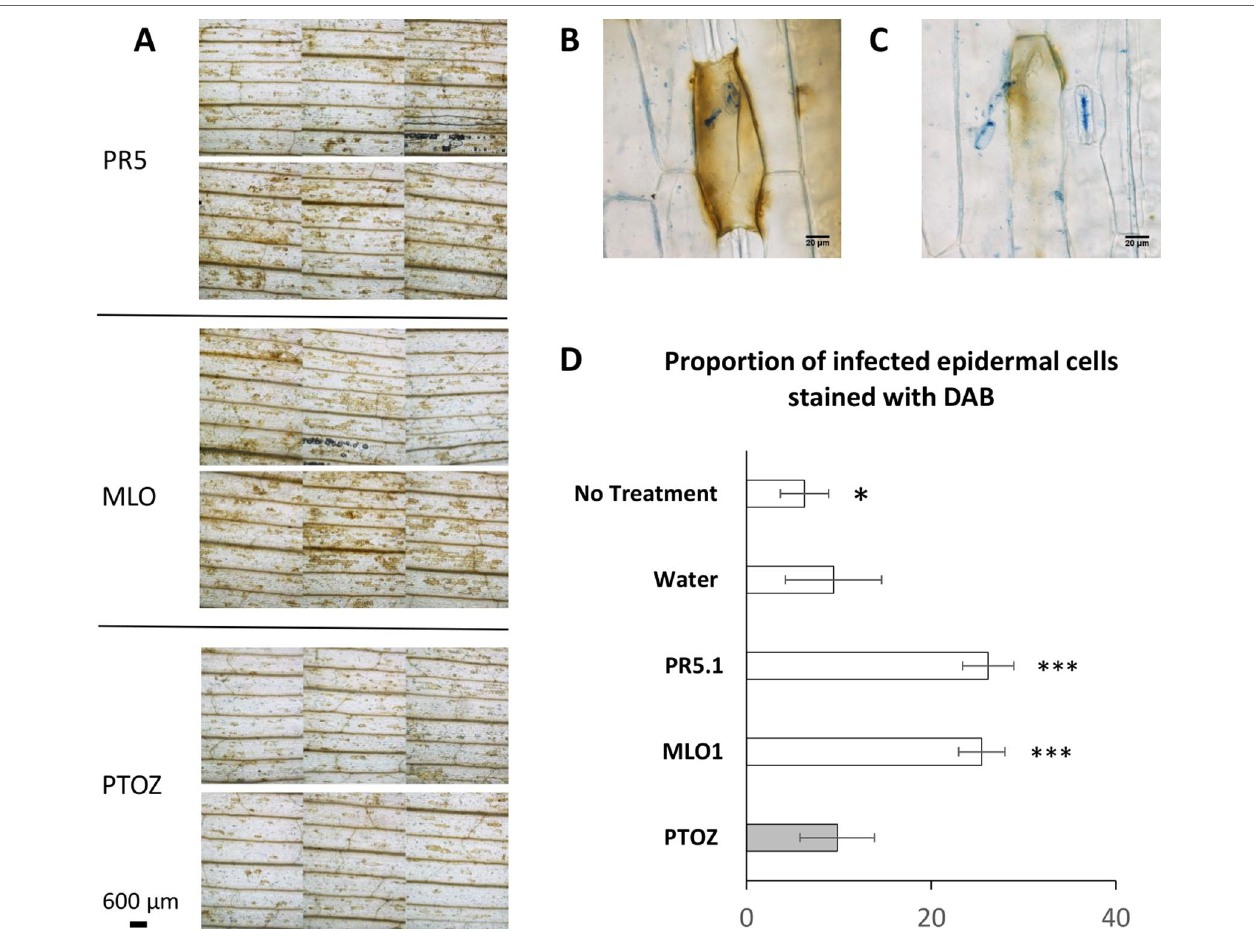
FIGURE 6 | PTO MLO1-, PTO PR5.1-, and PTOZ-treated leaves, inoculated with Bgh conidia, were stained with 3,3 ′ -diaminobenzidine (DAB) to detect H 2 O 2 production in barley epidermal cells in response to Bgh inoculation at 18–22 hpi. Leaves were subsequently stained and cleared with lactophenol blue to visualize fungal structures and DAB-stained epidermal cells. (A) , Micrographs of PTO PR5.1-, PTO MLO1-, and PTOZ-treated leaves showing different intensities of DAB staining. Six panels are shown for each treatment, corresponding to each individual leaf from a typical experiment. Pictures were taken at 1.5 cm from the leaf tip, in bright field settings, at 40× magnification. (B – C) , Illustration of a DAB-stained barley cell indicating two degrees of H 2 O 2 production in response to a germinated Bgh conidium. (D) , Graph showing the average (± SD) proportion of epidermal cells producing H 2 O 2 following Bgh infection. This was monitored as the % of DAB-stained cells associated with germinated conidia (partial or whole cell response), comparing leaves from the PTOZ negative control treatment with PTO MLO1, PTO PR5.1, and the additional negative controls, “water,” and “no-treatment” leaves. N = 18 leaves from three independent biological replicates. Significance was calculated with one-way ANOVA and post-hoc Tukey HSD tests. Significance: * indicates P < 0.05; ** indicates P < 0.01; *** indicates P < 0.001. DAB, 3,3 ′ -diaminobenzidine; ANOVA, analysis of variance; HSD, honestly significant